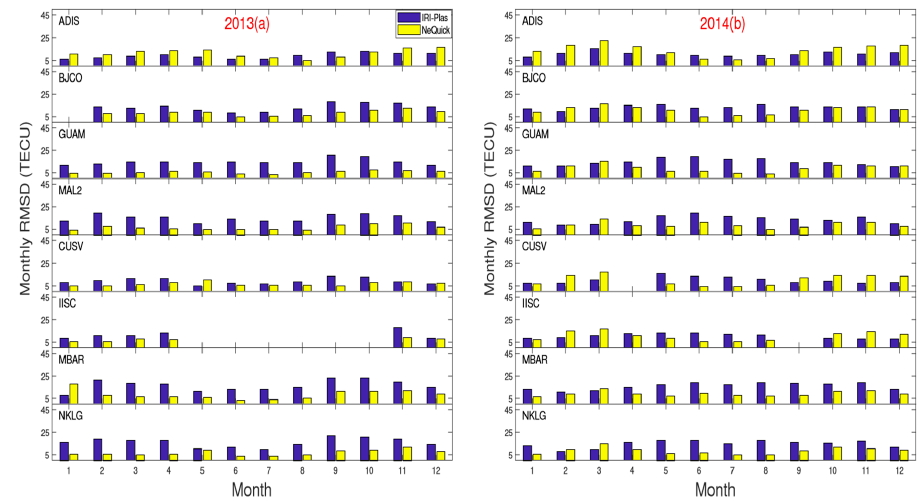
Figure 4. Monthly RMSDs for the year 2013 ( a ) and 2014 ( b ) for all the stations.